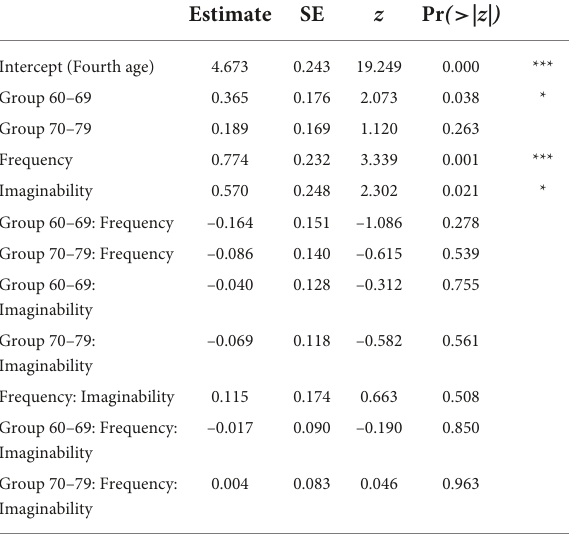
TABLE 6 Generalized linear mixed-effects regression accuracy results for Experiment